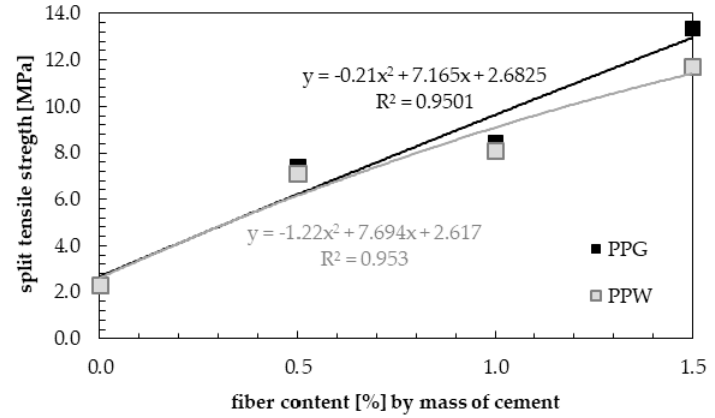
Figure 17. Split tensile strength of hardened samples with PPG and PPW.